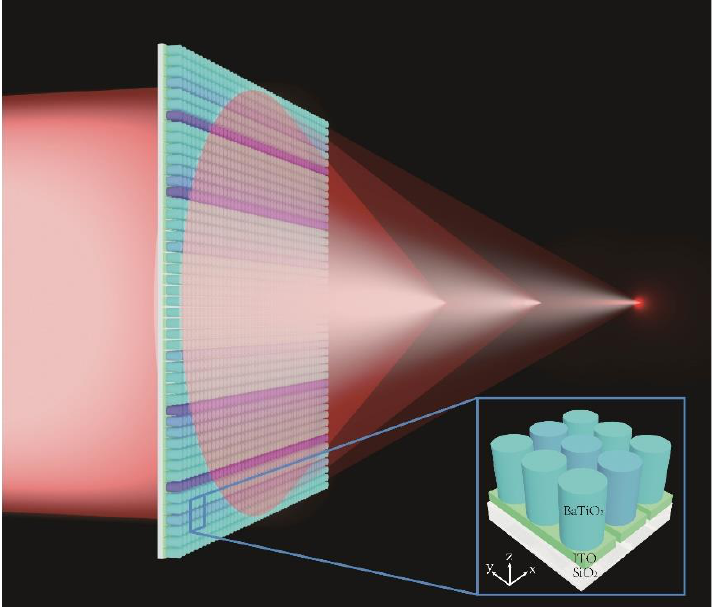
Figure 1. Schematic of electrically driven zoom metalens (EZM) (1D) in visible light. The illustration shows the arrangement of the barium titanate (BTO) antennas that we only change the voltages of antennas instead of the radius.